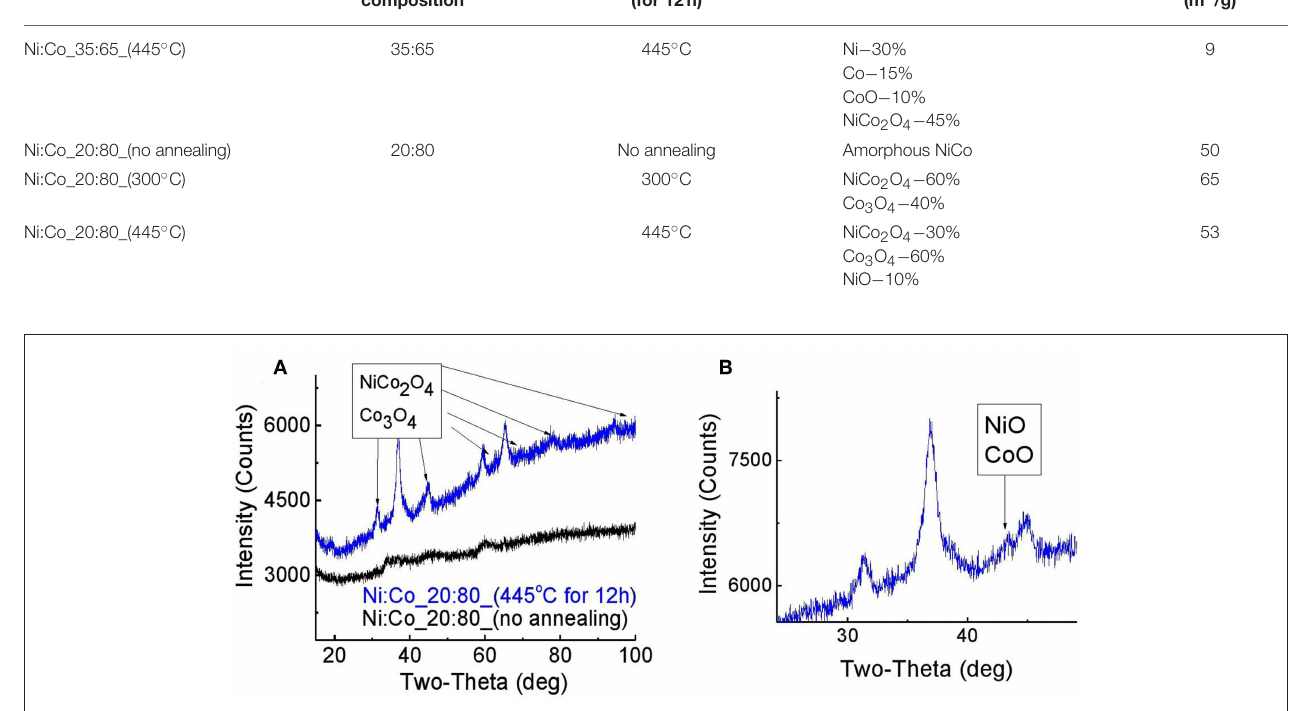
Annealing temperature Crystallographic phase BET surface area composition (for 12h)